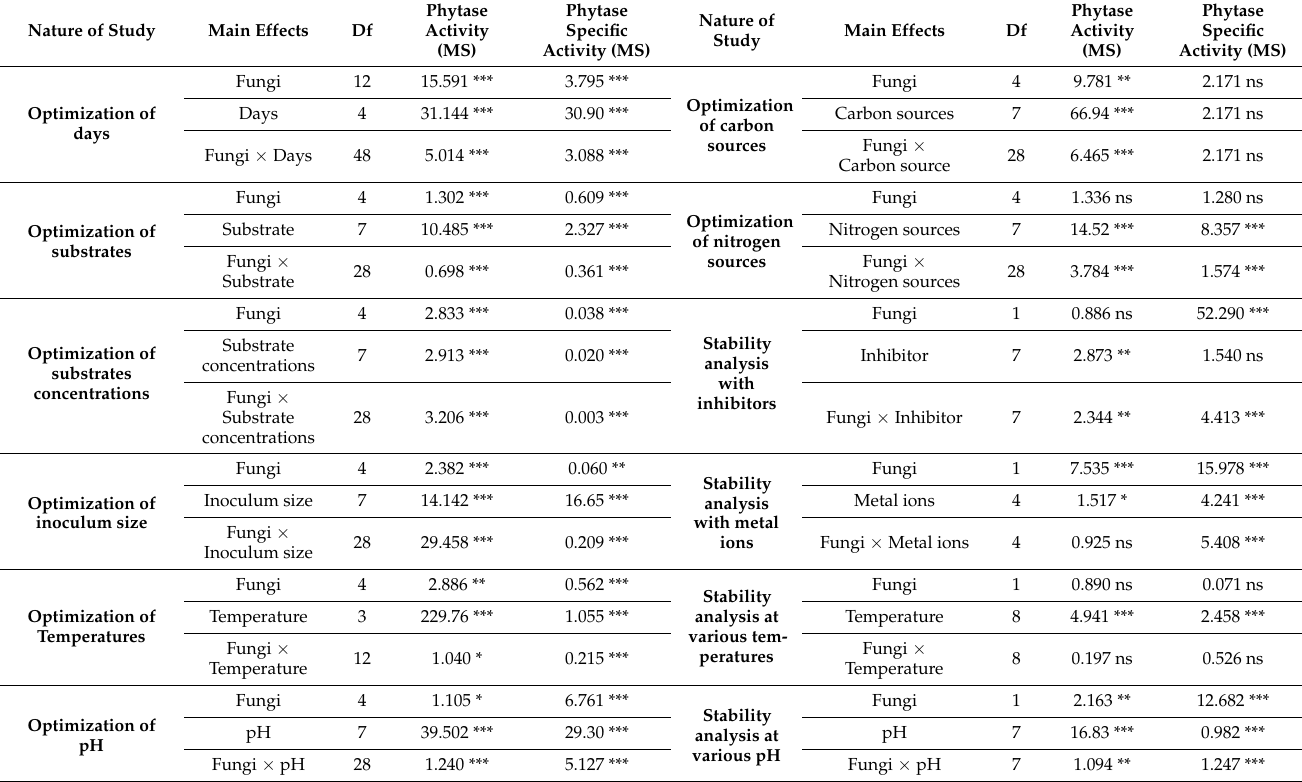
Table 1. Mean squares from analysis of variance (ANOVA) of data for phytase activity and phy- tase specific activity of the selected fungi during the independent experiments for each treatment. df = degree of freedom; x = interaction between the studied parameters and the selected fungi; MS = mean